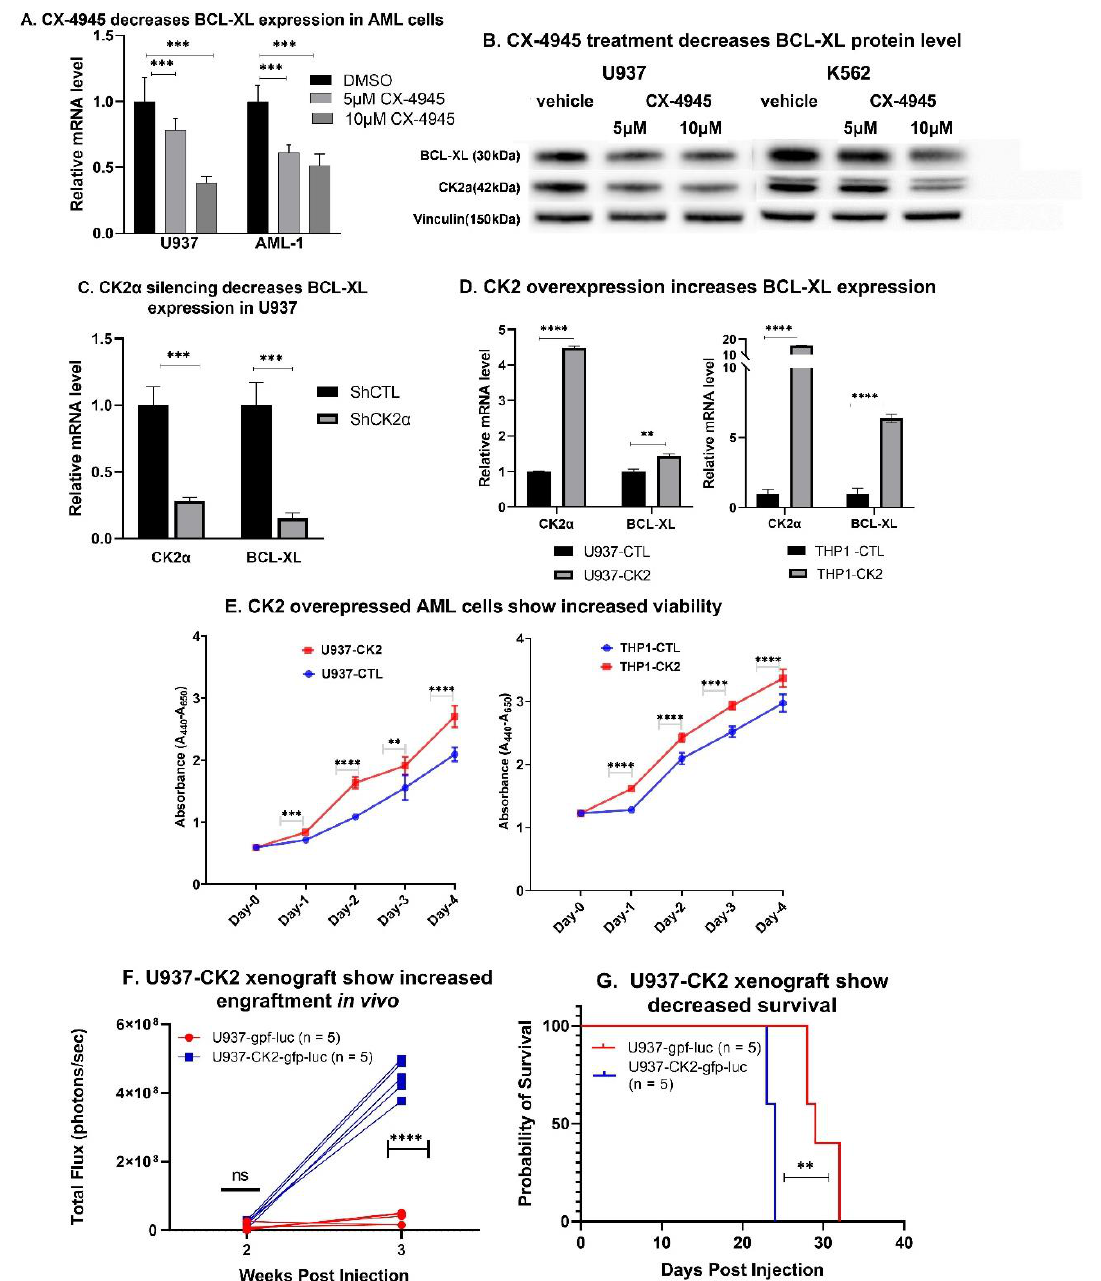
Figure 2. CK2 inhibition suppresses BCL-XL expression in AML cells and xenograft model. ( A ) U937 and AML-1 were treated with 5 and 10 µM concentration of CX-4945 for 48 h before RNA and protein extraction. mRNA level of BCL-XL was measured by qRT-PCR. ( B ) U937 and K562 cells were treated with 5 and 10 µM of CX-4945 for 48 hours and protein was extracted. BCL-XL protein level was measured by western blot. ( C ) Downregulation of CK2α in U937 was achieved using shRNA. Validation of CK2α protein knockdown in U937-shCK2α cell line is shown in Figure S3. qRT-PCR shows mRNA level of CK2α and BCL-XL in CK2α shRNA treated U937 cells. ( D ) Overexpression of CK2α was achieved by retroviral transduction of U937 cells. Validation of CK2α protein overexpression is shown in Figure S6. qRT-PCR showed increased BCL-XL mRNA level in CK2α overexpressed U937 (left panel) and THP-1 cells (right panel). ( E ) WST assay showing increased cell viability in CK2α overexpressing U937 and THP-1 cells. U937 cells transduced with retroviral vector CK2α-gfp-luc were transplanted into NRG-S mice. 25,000 cells were injected via the tail vein. Bioluminescence imaging using IVIS 100 was obtained weekly following transplant. ( F ) Bioluminescence signal in xenograft mice engrafting U937-gfp-luc cell or control (U937-ctl-gfp-luc) shown at week 2 and 3 post transplantation. ( G ) Kaplan Maier plot showing survival probability in U937-CK2-gfp-luc cells vs control. P -value summaries are as follows: p > 0.05 (ns-not significant); p < 0.01 (**); p < 0.001 (***); p < 0.0001 (****).